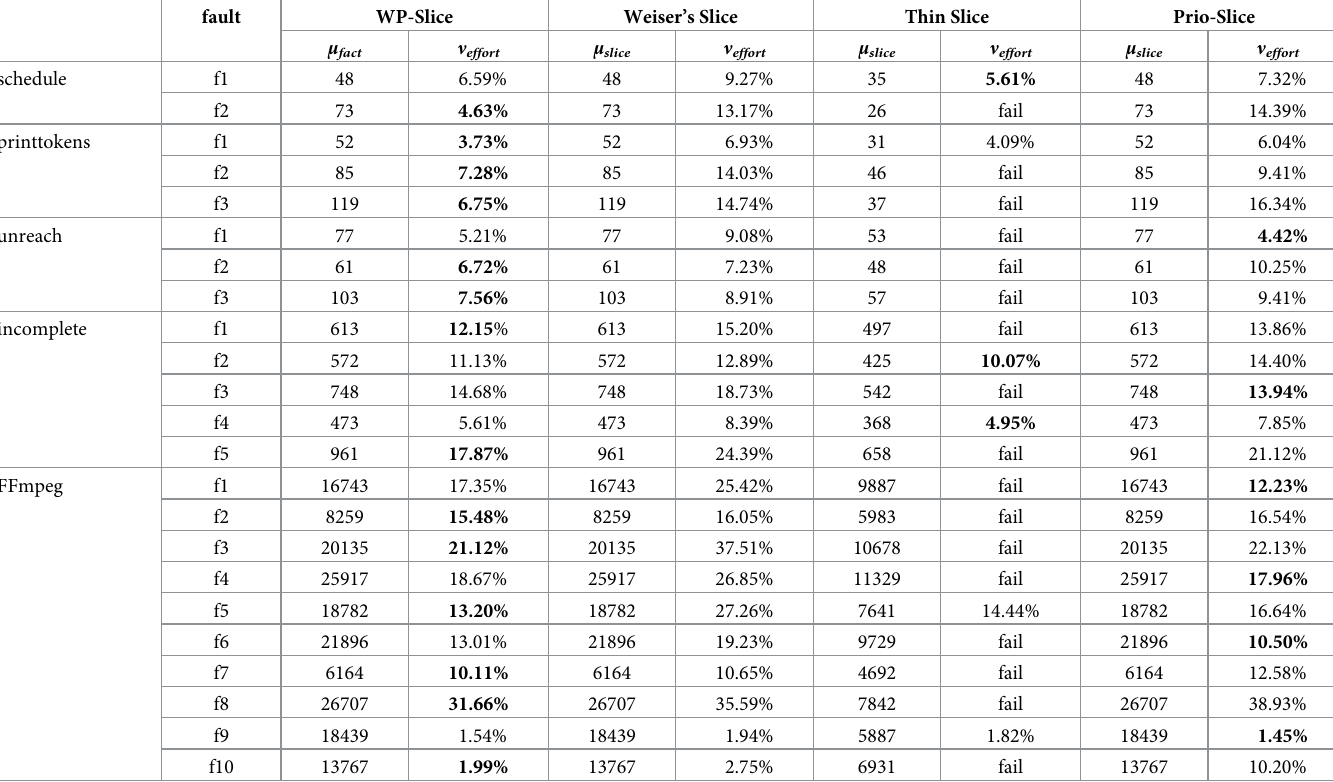
Table 5. Comparison of slice fact( μ fact ) or slice size( μ slice ) and localization effort( ν effort ) among WP-Slice, weiser’s slice, thin slice and prio-slice. fault WP-Slice Weiser’s